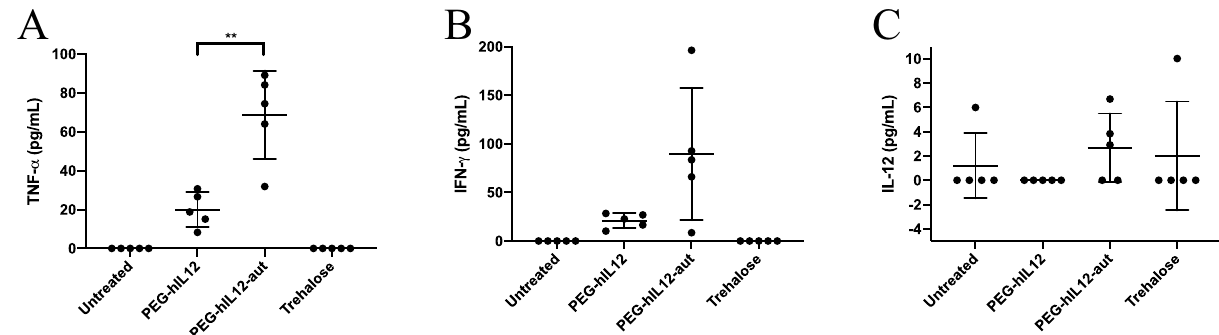
Figure 1. Grouped plots for cytokine stimulation in CD-1 mice. Following treatment with l-PEI/DNA nanoparticles formulated with plasmids PEG-hIL12 (43 CpGs) or PEG-hIL12-aut (152 CpGs), or 9.5% trehalose, or left untreated, the levels of endogenous TNF-α ( A ), IFN-γ ( B ) and IL-12 ( C ) were assayed. A significant difference (paired t-test, p < 0.01) was noted between PEG-hIL12 and PEG-hIL12-aut in the stimulation of TNF-α ( A ). There was no significant difference (paired t-test, p < 0.05) between PEG-hIL12 and PEG-hIL12-aut in the stimulation of IFN-γ ( B ) or endogenous murine IL-12 ( C ).